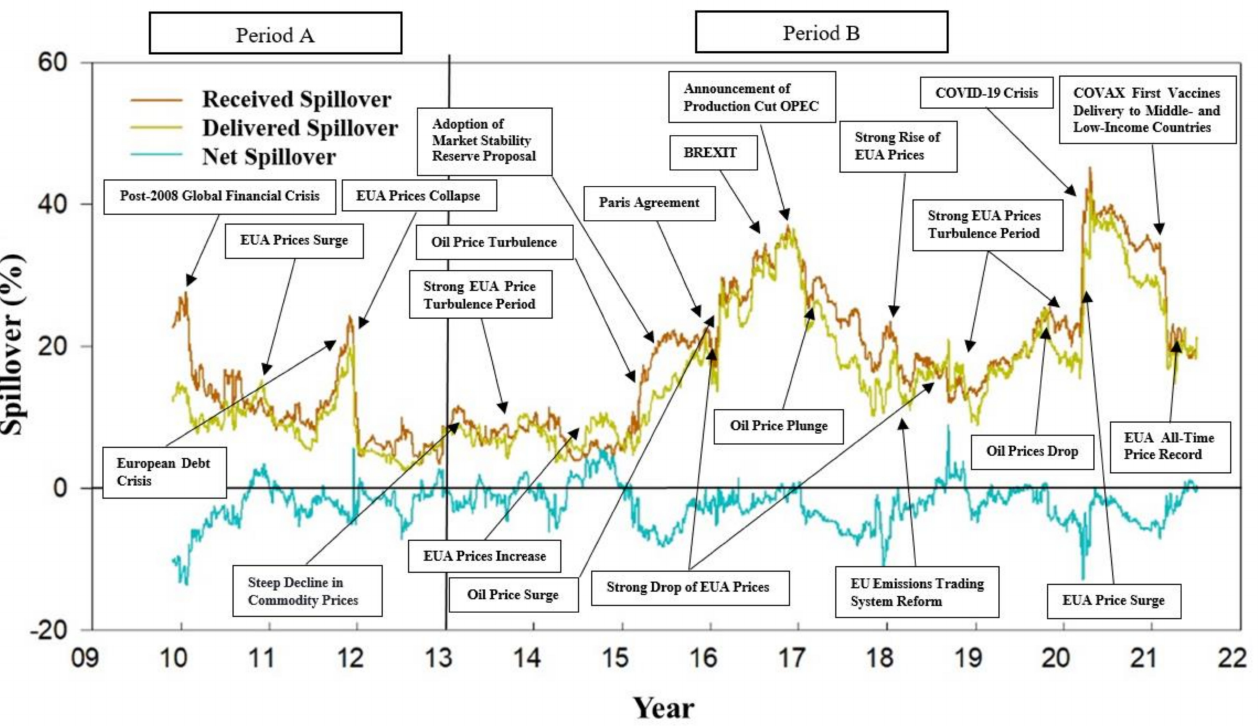
Figure 5. Spillover Plot of Received, Delivered and Net Return Spillovers of the Carbon Market in the “Carbon-Energy” Market System. Note: We plot the time series of the received, delivered and net return spillovers of the CE market in the “Carbon-Energy” system based on 252-day rolling samples for the period from 1 December 2009 to 8 July 2021. The underlying variance decompositions are based on VAR models with lag orders of 6, as suggested by the AIC. The forecast horizon is 5 days. In the plot, we mark the major market and political events during the studied